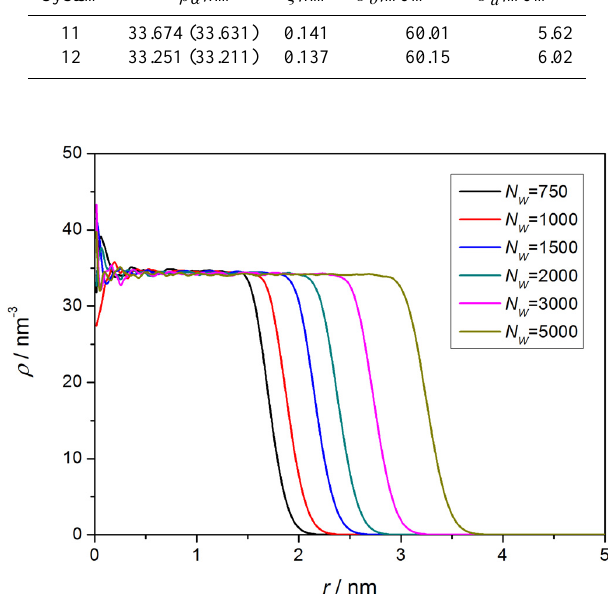
Fig. 1. Radial number densities of water molecules in systems 1–6.